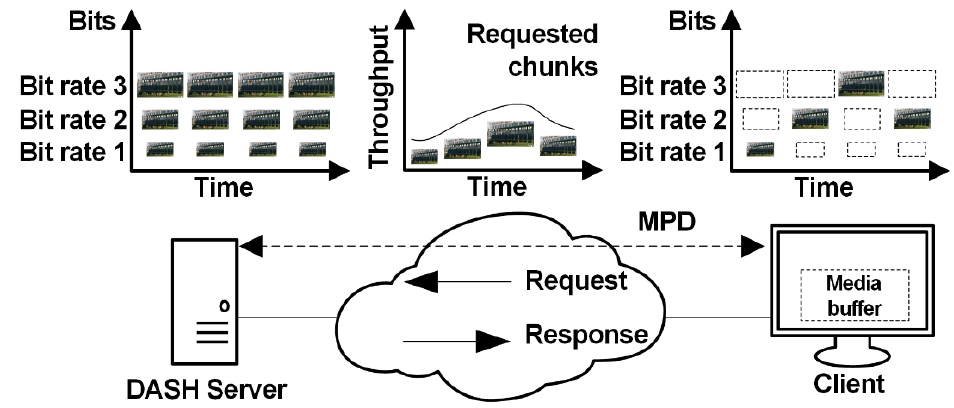
Figure 1. Communication in HTTP adaptive streaming systems. MPD, media presentation description; DASH, dynamic adaptive streaming over HTTP.